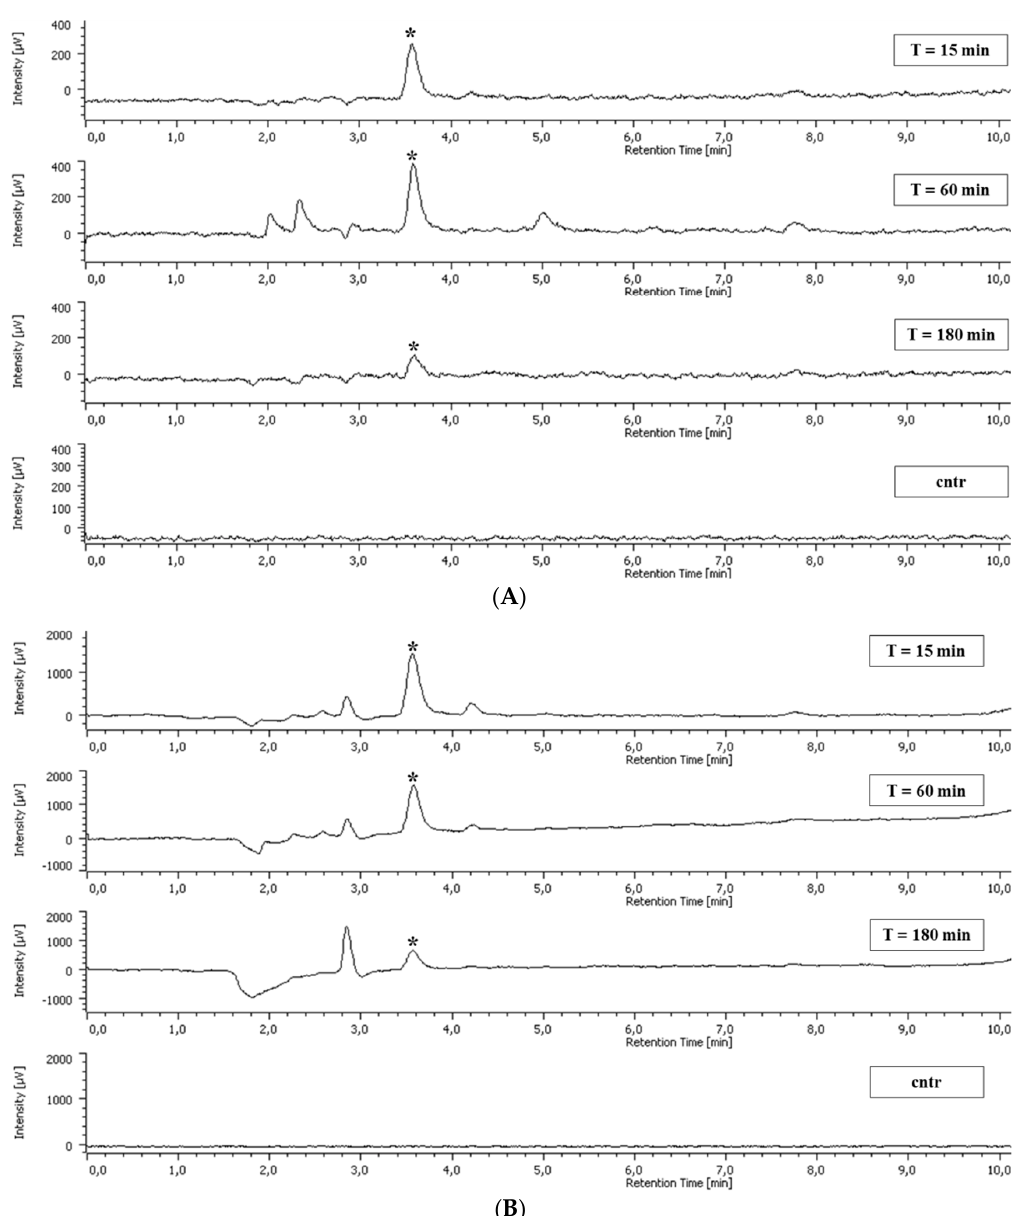
Figure 3. Representative chromatograms showing the resolution of the methanol extract of intestinal intraepithelial non-adherent leukocytes ( A ) incubated with chestnut shell extract (CSE) and blood non-adherent leukocytes ( B ) incubated with gallic acid (GA) for 15, 60, and 180 min. The control was the cellular sample incubated in the absence of CSE. Asterisks represent the GA peak (retention time = 3.59 min).